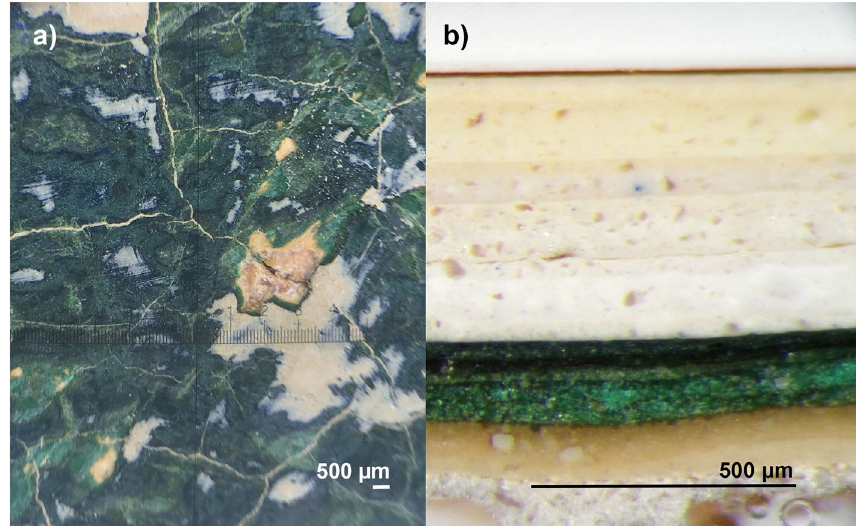
Fig. 6 a Detail seen through a magnifying glass, showing the original green paint layer exposed at the site. Where the upper darker finish was scratched off during exposure, the brighter, intense-green lower layer became visible. b Photomicrograph of a polished cross section of the same green colour layers. (Source: the